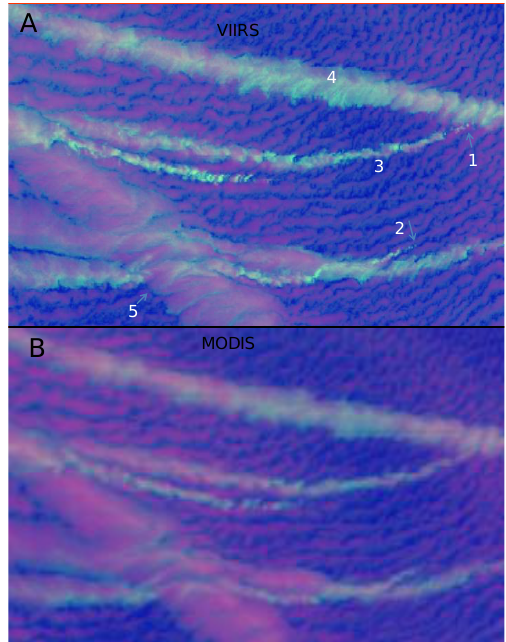
Fig. 1. Microphysical RGB composite imagery of ship tracks, as seen by VIIRS (22:20UT, panel A ) and MODIS (22:40UT, panel B ) overpasses on 15 July 2012 over the northeastern Pacific in an area of 174km × 107km centered at 40.55 ◦ N, 140.09 ◦ W. The images show the same area and are scaled to show the full resolu- tion of 375m of the VIIRS imager. This results in a blurred picture of the ship track in the MODIS image due to its lower resolution of 1000m.